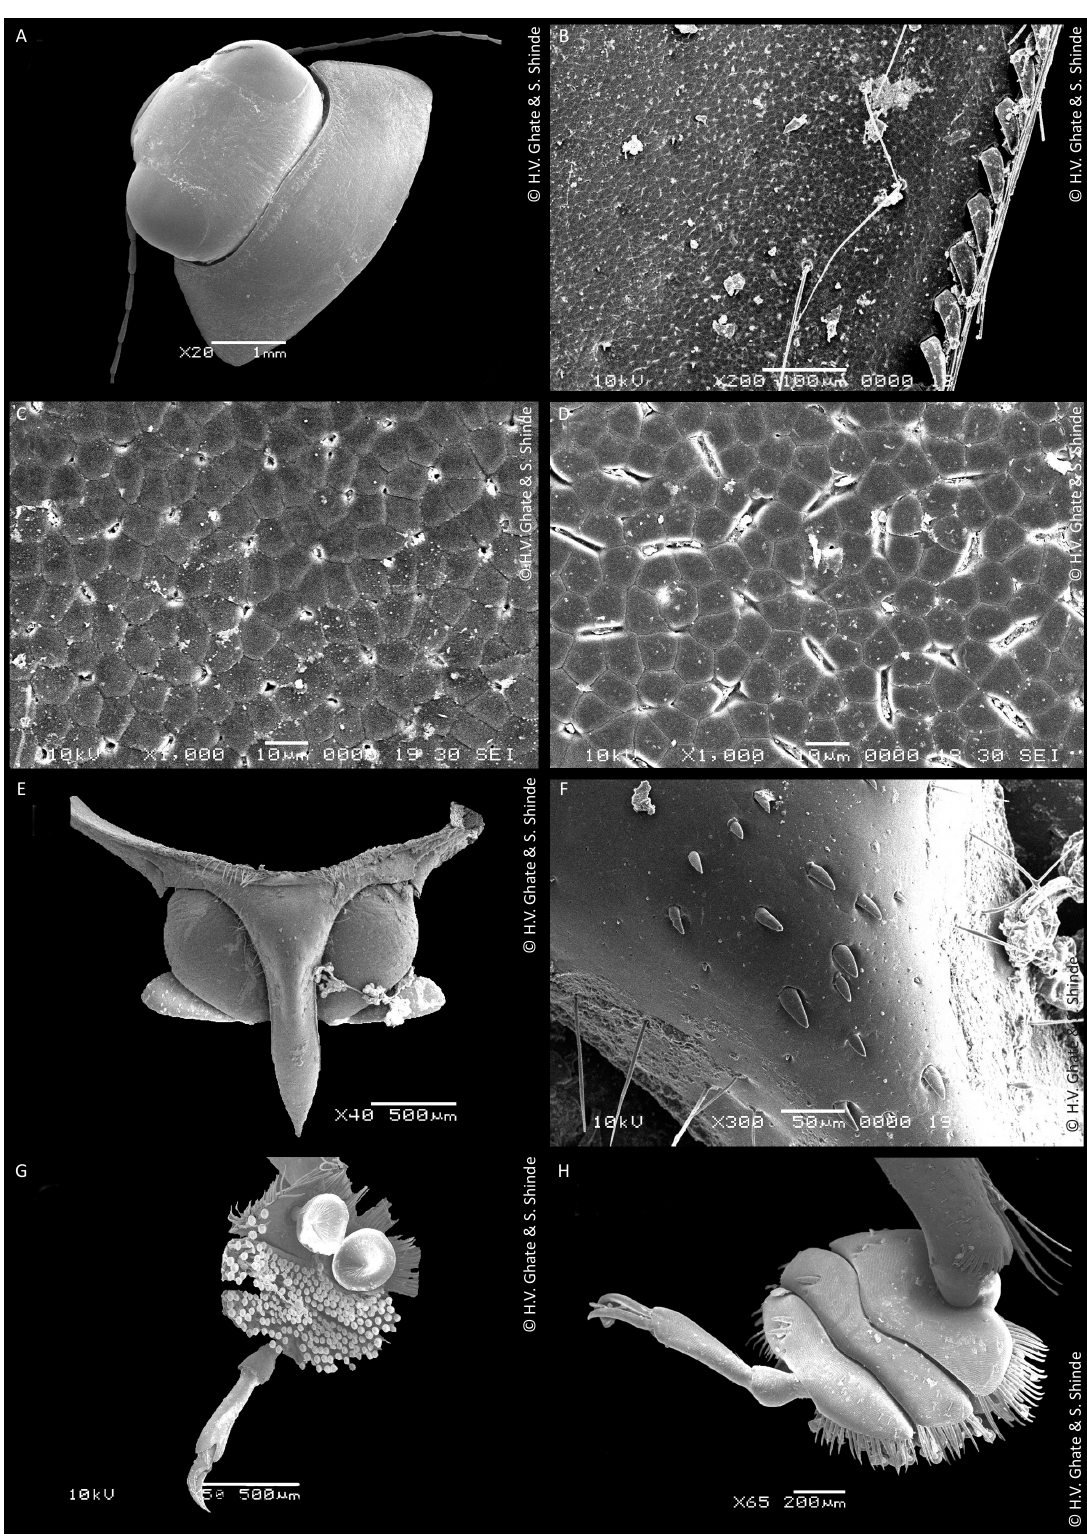
Image 2. SEM illustrations of E. griseus . A - Head and pronotum, with anterior row of setae bearing punctures; B - Elytral edge, as seen dorsally, with spines, and long thin setae in-between; C - Elytral dorsal micro-sculpture of male, with small pits in-between the polygonal facets; D - Elytral dorsal micro-sculpture of female, note the larger elongate pits as compared with those present in male; E - Prosternal process; F - Enlarged view of prosternal process, minute setae are visible at this magnification; G - Ventral view of protarsal palette, with two large suckers and numerous small adhesive setae; H - Dorsal view of protarsal palette showing adpressed